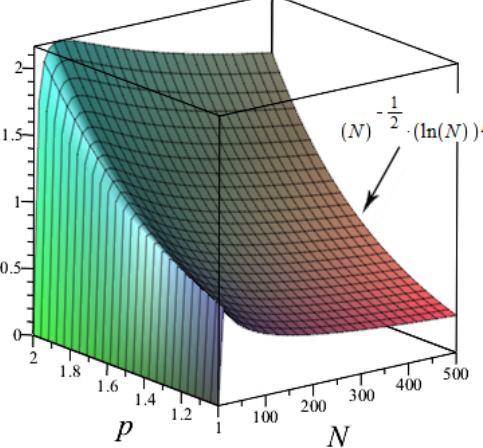
Figure 3. Graph of y = N − 1/2 ( ln N ) p for 1